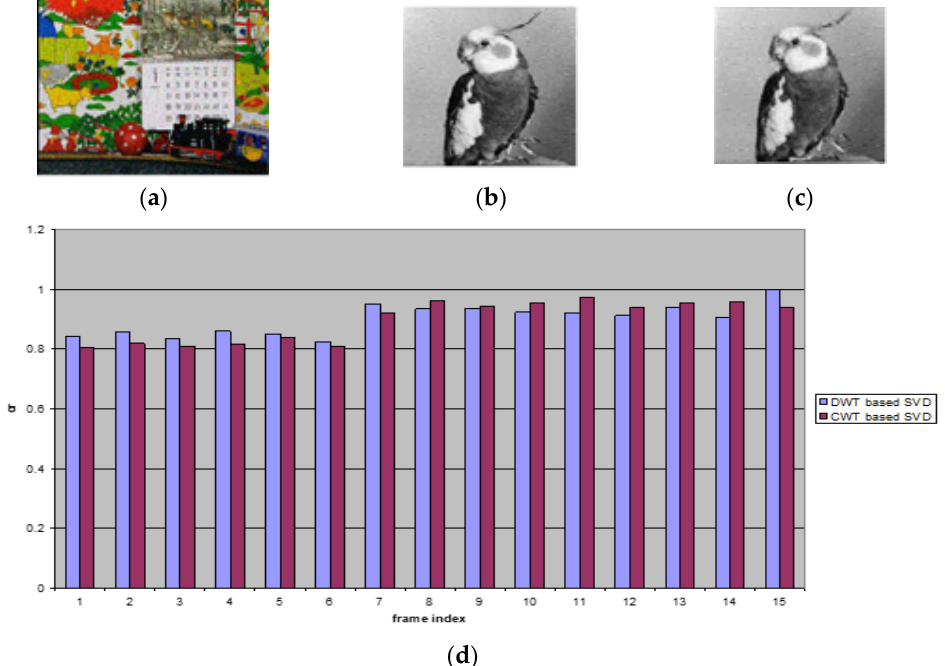
Figure 11. ( a ) The watermarked frame under Gaussian noise attack using the proposed method. ( b ) Extracted watermark from frame 10 of the first video scene in the proposed method. ( c ) Extracted watermark from frame 10 of the first video scene in the DWT-based SVD method. ( d ) Correlation values for the extracted watermarks for frames 1 to 15 in the first video scene under Gaussian attack.